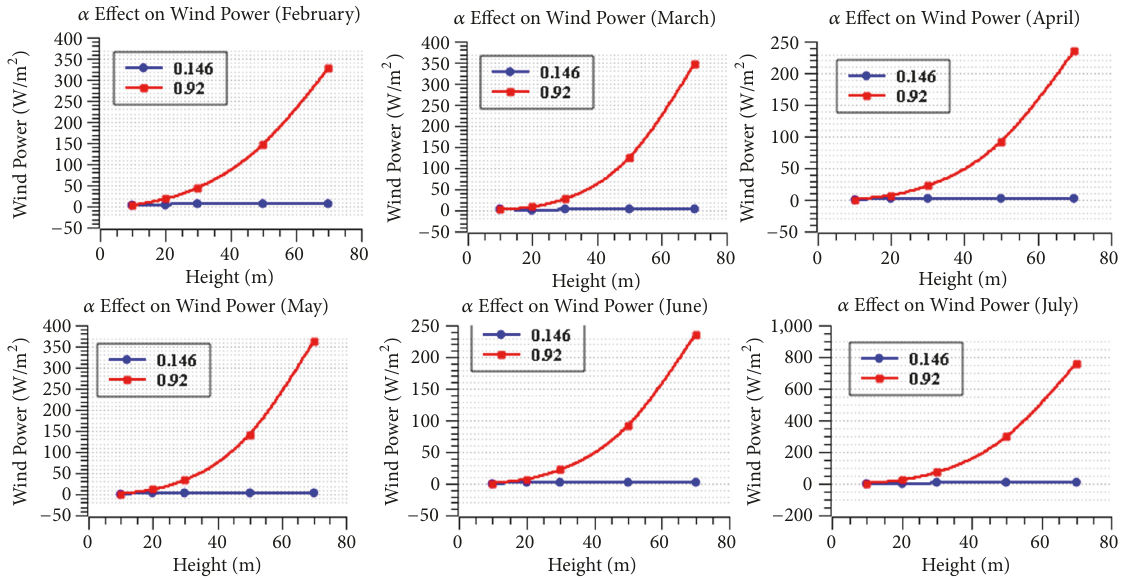
Figure 3: Effect of wind shear exponent on wind energy yield for Nyamecheo station.